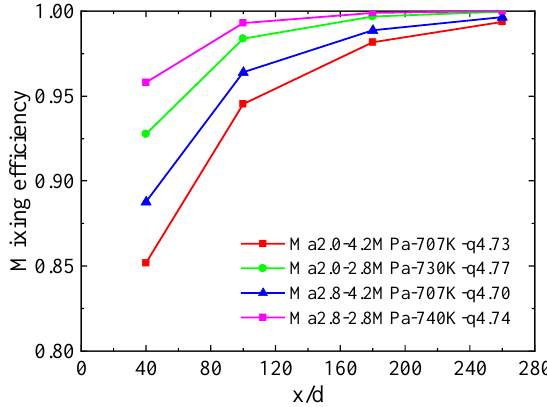
Figure 16. Mixing efficiency at different Mach numbers.